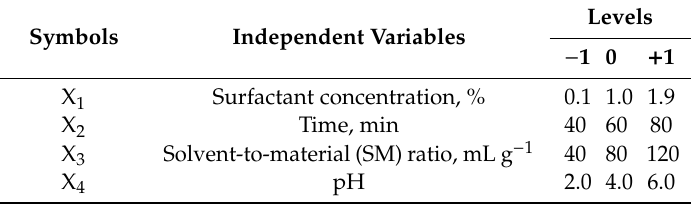
Table 1. Levels of variables for the experimental